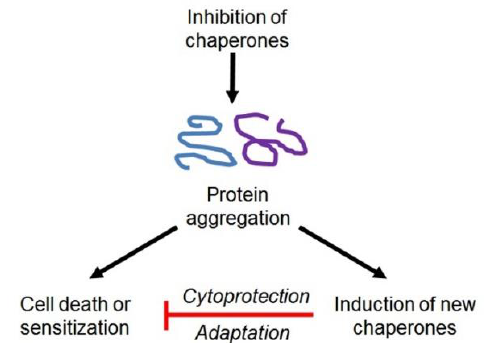
Figure 5. A simplified scheme outlining an undesirable situation that may take place under the use of cell-penetrating inhibitors of the chaperone activity against tumors. The dysfunction of intracellular chaperone(s) will result in the accumulation and aggregation of misfolded proteins, which will trigger the induction of new cytoprotective chaperones, thus adapting target tumor cells and rendering them more resistant to cytotoxic drugs and radiation exposure. This problem may especially be actual for functional inhibitors of cytosolic HSP90 or HSP70, whose inactivation can provoke the HSF1-mediated expression of inducible HSPs and also MDR1 (see the text for details).